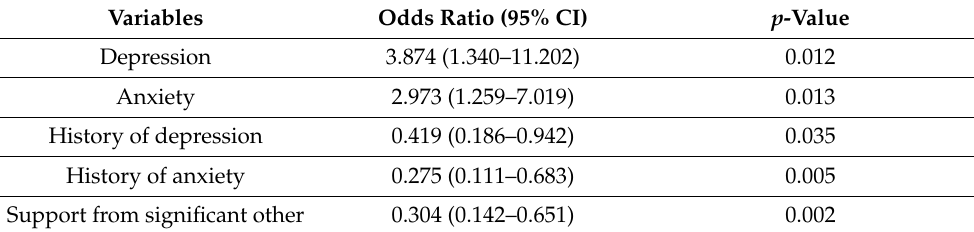
Figure 1. The cross-sectional association of perinatal affective instability, depression, and anxiety. History of depression and history of anxiety were strongly associated with current AI. To assess whether the associations were due to including women who experienced depression and/or anxiety currently, we examined the associations by excluding women with current depression and/or anxiety, respectively, and the results showed that his- tory of depression and history of anxiety were still significantly linked with current AI (t(151) = 3.57, p = 0.001; t(142) = 3.44, p < 0.001 respectively). Table 3. Multiple logistic regression results of associations between AI and depression, anxiety, and other variables ( n =